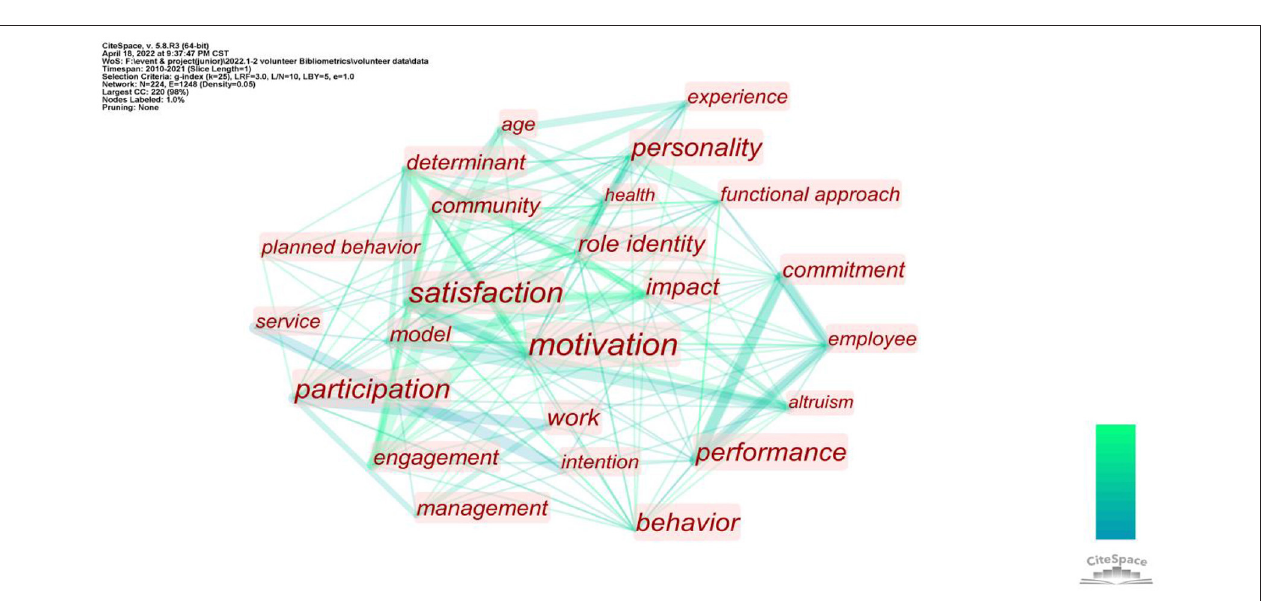
FIGURE 5 | Keyword network between 2011 and 2021 (Threshold for inclusion is a minimum of four